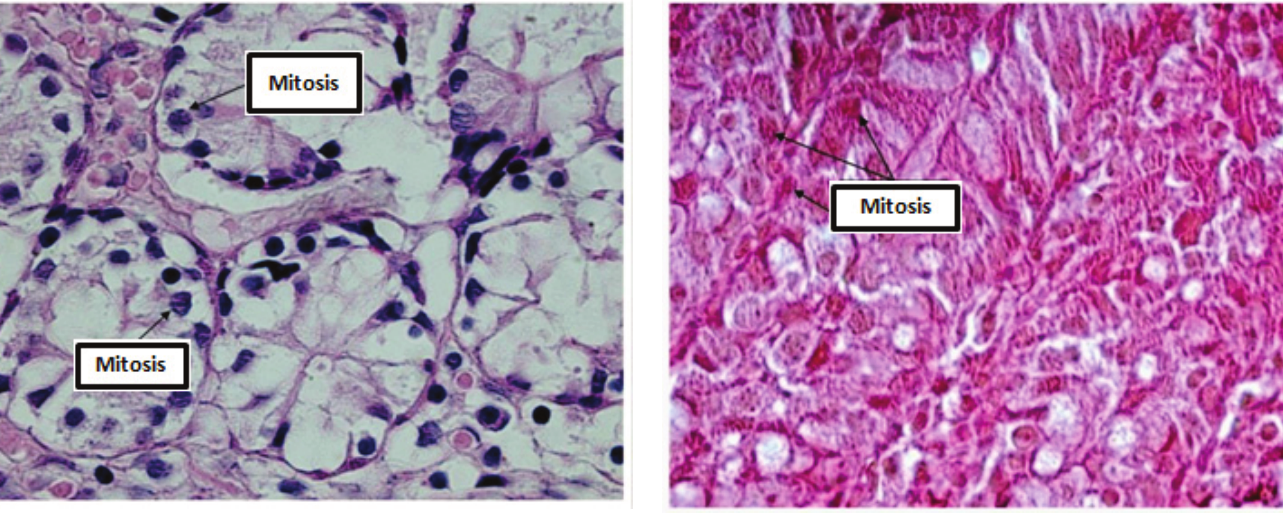
FIGURE 4 - Histological aspect of the animal 5 in the nitrite+vitamin C control group. Mitotic figure in segment S